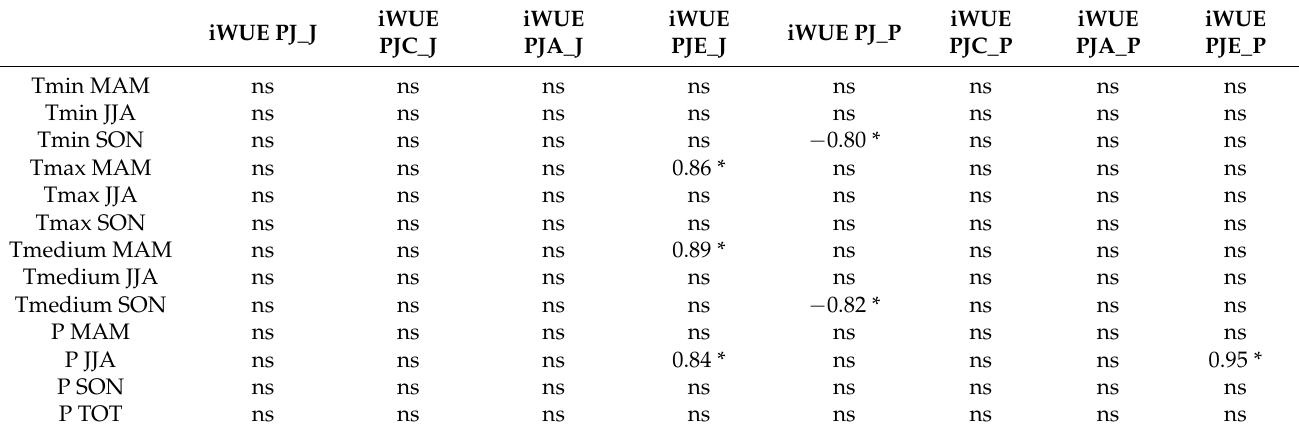
Table 2. Correlations between water use efficiency (iWUE) of each intercropping systems with average temperature (Tmean), minimum temperature (Tmin), maximum temperature (Tmax), and total precipitation (Ptot) grouped seasonally (MAM = March, April and May; JJA = June, July and August; SON = September, October and November). Spearman correlation coefficients are reported (r), with the corresponding statistical significance (* 0.05), n =